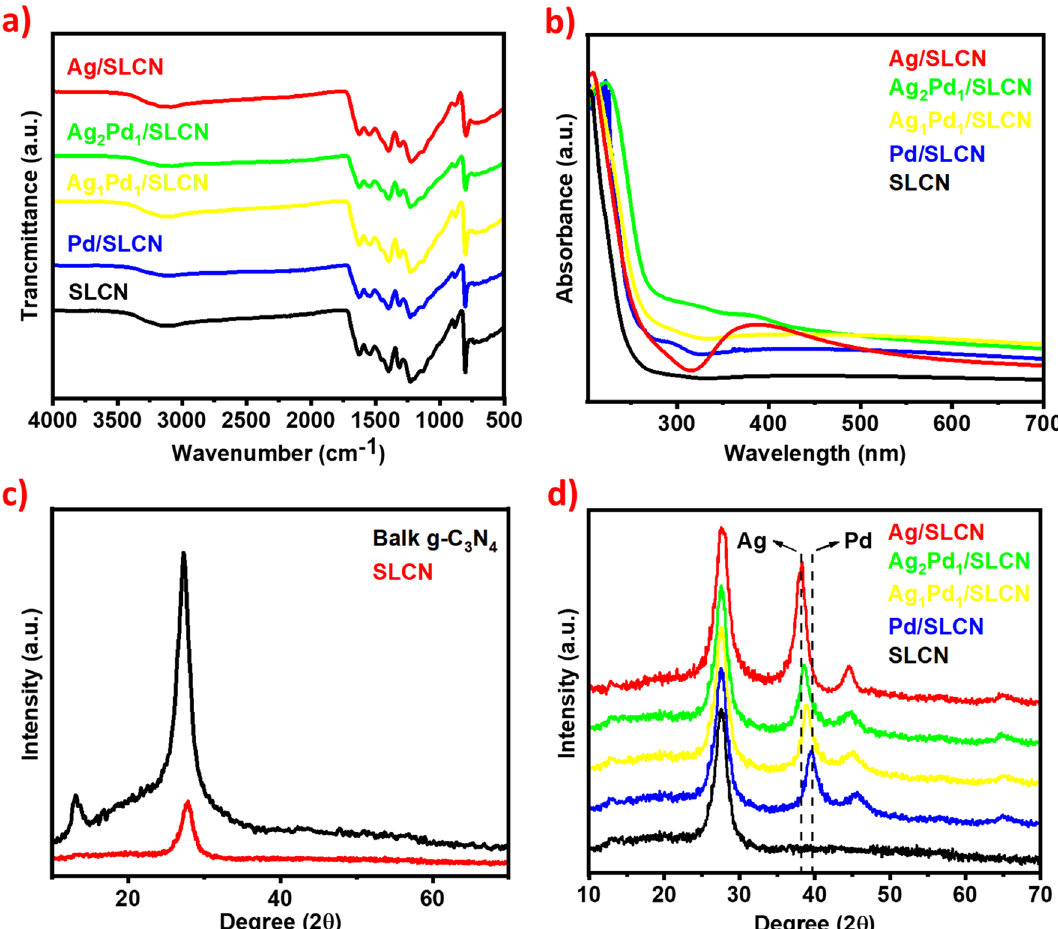
Figure 2. ( a ) FT-IR spectrum, ( b ) UV–vis spectra of SLCN, Ag/SLCN, Ag 2 Pd 1 /SLCN, Ag 1 Pd 1 /SLCN and Pd/ SLCN, ( c ) XRD patterns of the bulk g-C 3 N 4 and SLCN, ( d ) XRD patterns of SLCN, Ag/SLCN, Ag 2 Pd 1 /SLCN, Ag 1 Pd 1 /SLCN and